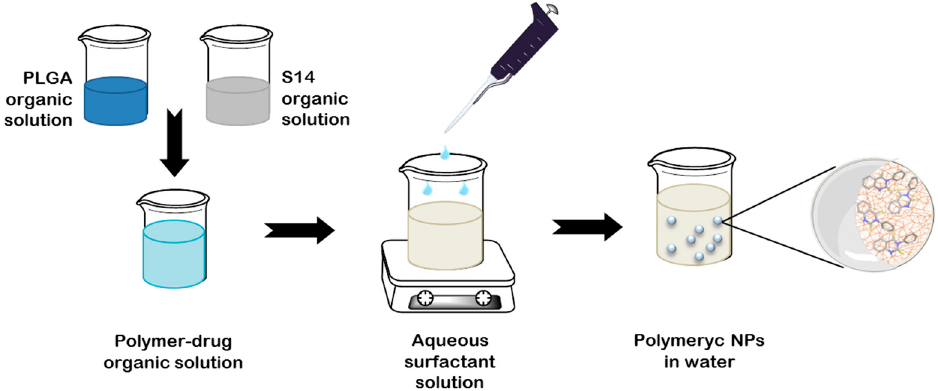
Figure 4. Schematic representation of the nanoprecipitation methodology.